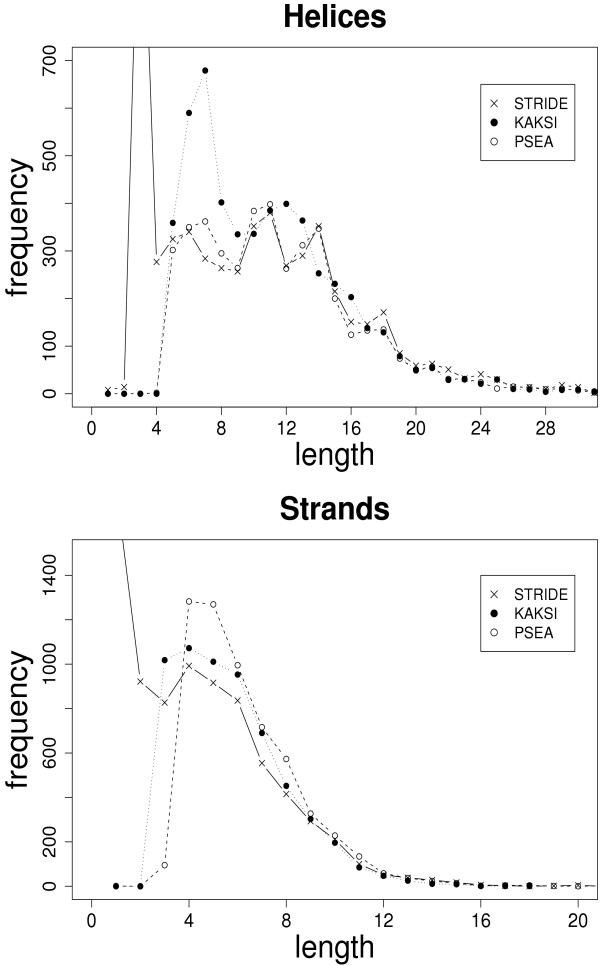
Length distribution of helices and strands assigned by stride, psea and kaksi. Length distribution of helical (top) and extended (bottom) segments assigned by STRIDE (plain line and crosses), PSEA (dashed line and open circles), and KAKSI (dotted line and filled circles), on the HRes set. The STRIDE assignment generates a large number of 3 residue-long helices (1238 segments) and 1 residue-long strands (corresponding to 1800 β-bridges).